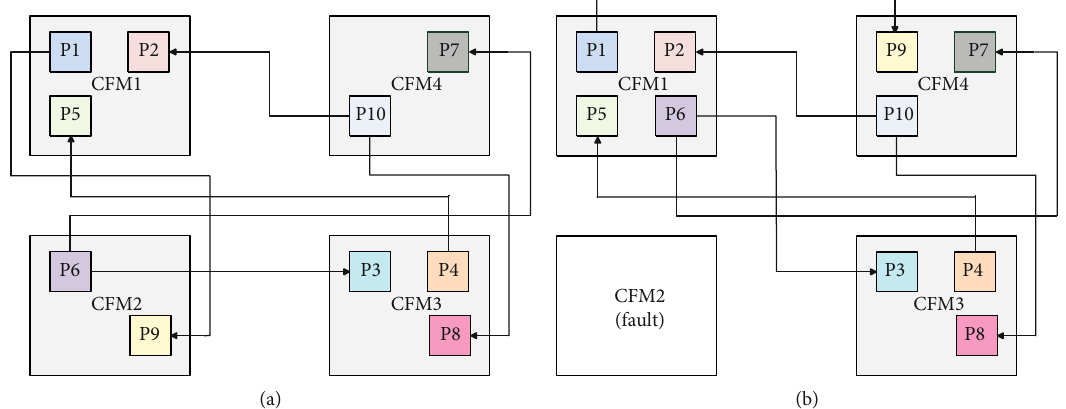
Figure 3: Con fi guration/recon fi guration for the hosted application “ Landing Gear System ” : (a) initial con fi guration; (b) correct recon fi guration after CFM2 fails.